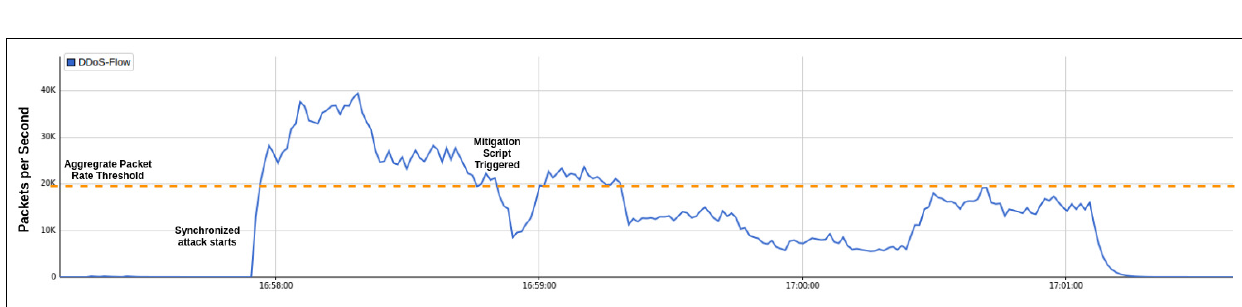
Figure 11. Synchronised attack - Protection